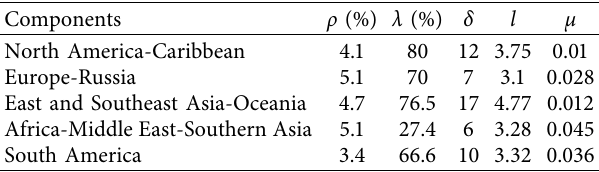
Figure 5: Te fgure at the left represents the fraction of nodes in the LCC of the large local and global components as a function of the fraction of removed nodes under a weighted betweenness attack on the world air transportation network. We also represent the LCC of the world air transportation network in this situation. Te Europe-Russia component and the global component are less sensitive to the attack. Te fgure at the right shows the weighted efciency of the large local and global components as a function of the fraction of removed nodes under a strength attack on the world air transportation network. We also represent the weighted efciency of the world air transportation network in this situation. Te weighted efciency of the world air transportation network and the large components are very sensitive to attacks based on the betweenness centrality. Table 4: Basic topological properties of the fve local components isolated by the betweenness attack. λ is the largest connected component size. ρ is the fraction of top strength nodes removed from the world air transportation network to isolate the compo- nent. δ is the diameter. l is the average shortest path length. μ is the